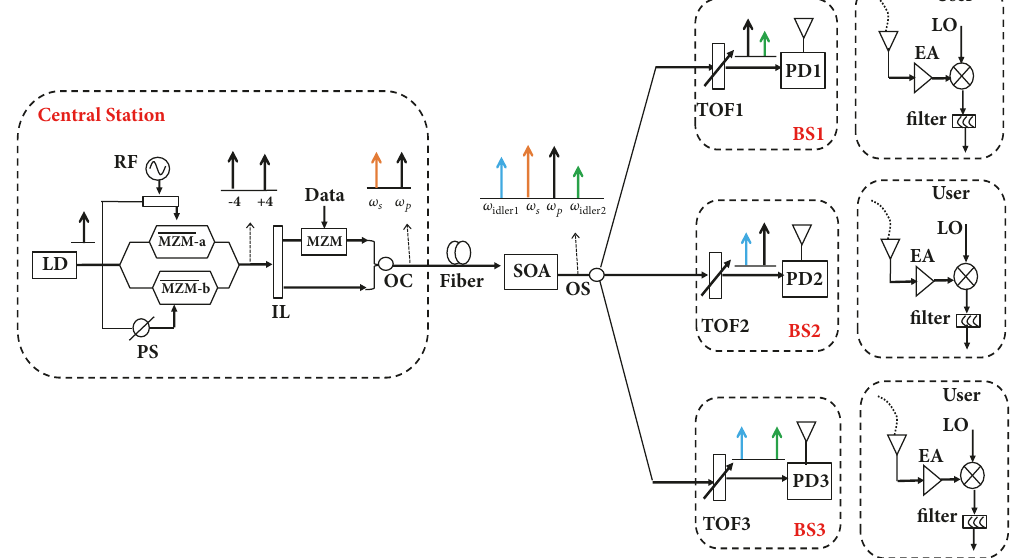
Figure 2: ROF architecture with multiband signals based on frequency octupling and FWM in SOA for multiple